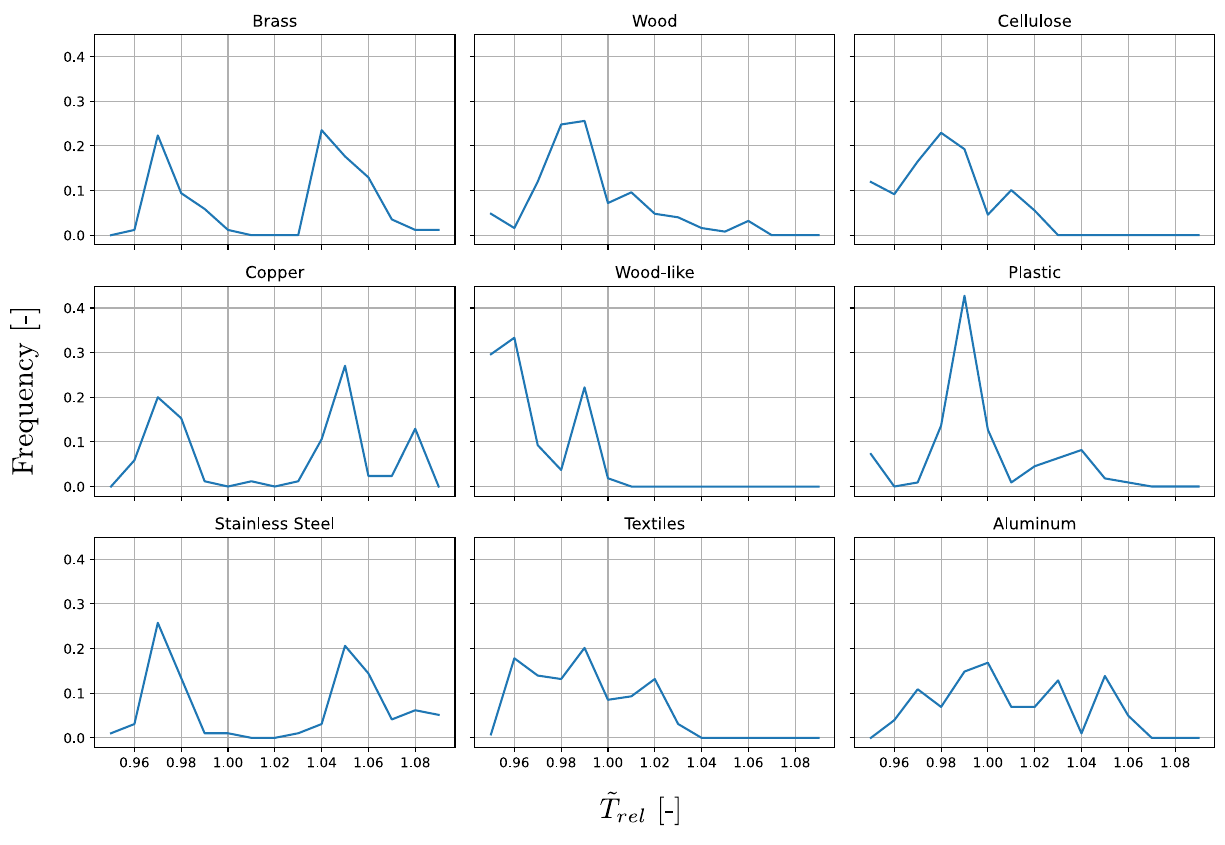
Figure 3. Histograms of the material specific median relative temperature ˜ T rel . As described in Algorithm 1, the temperature fields of each material sample were put into perspective with the respective ambient temperature. The median was then calculated for each temperature field. The distribution across the database is presented in the histograms above.